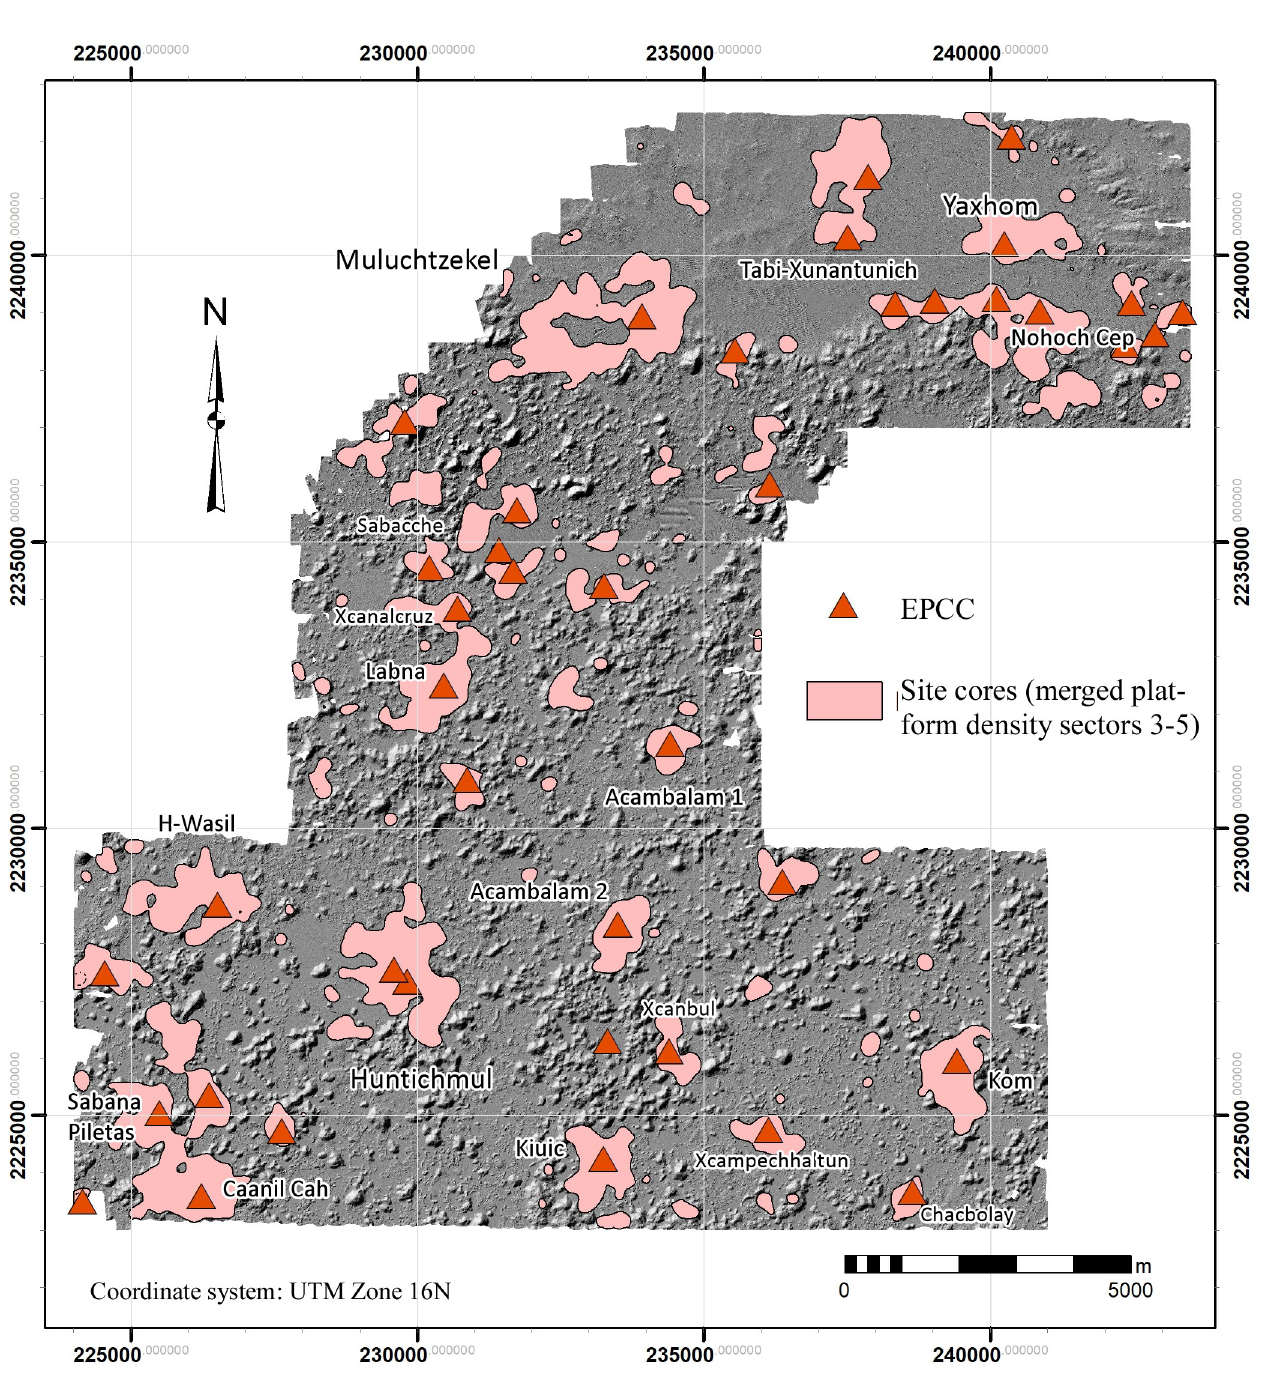
Fig 15. Locations of Early Puuc Civic Complexes (EPCCs) within the lidar sample.